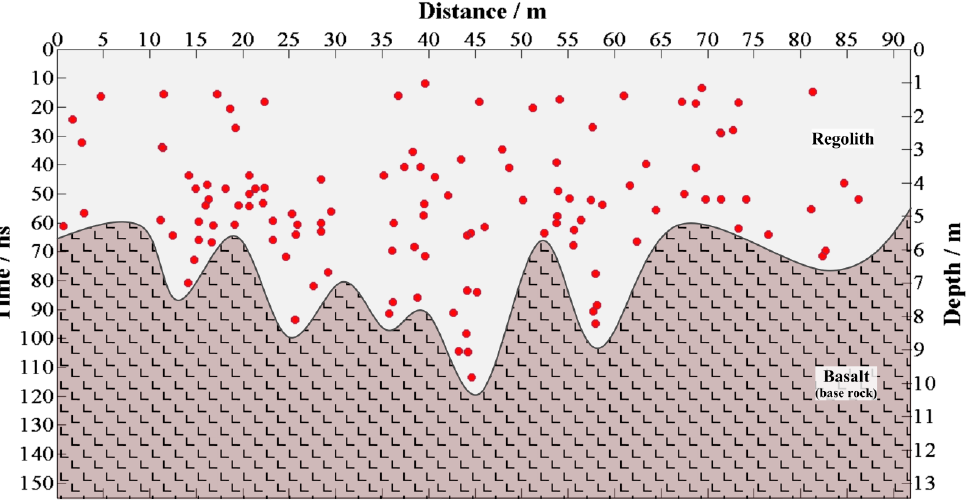
Figure 13. The interface of regolith and base rock. The relative dielectric constant is set to 3.